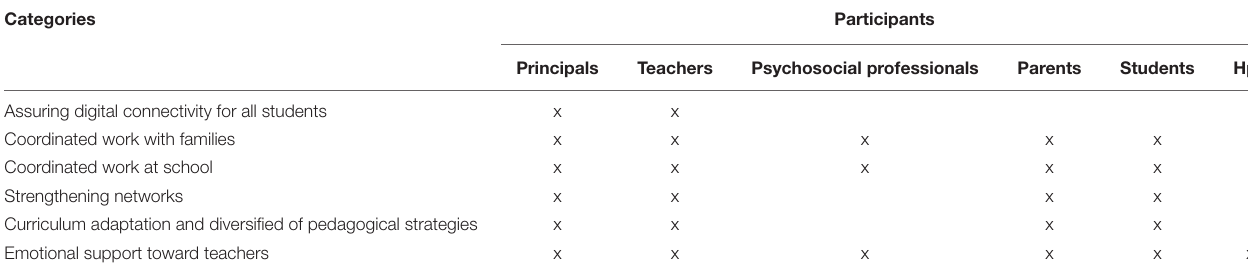
TABLE 3 | Analytical categories per type of school